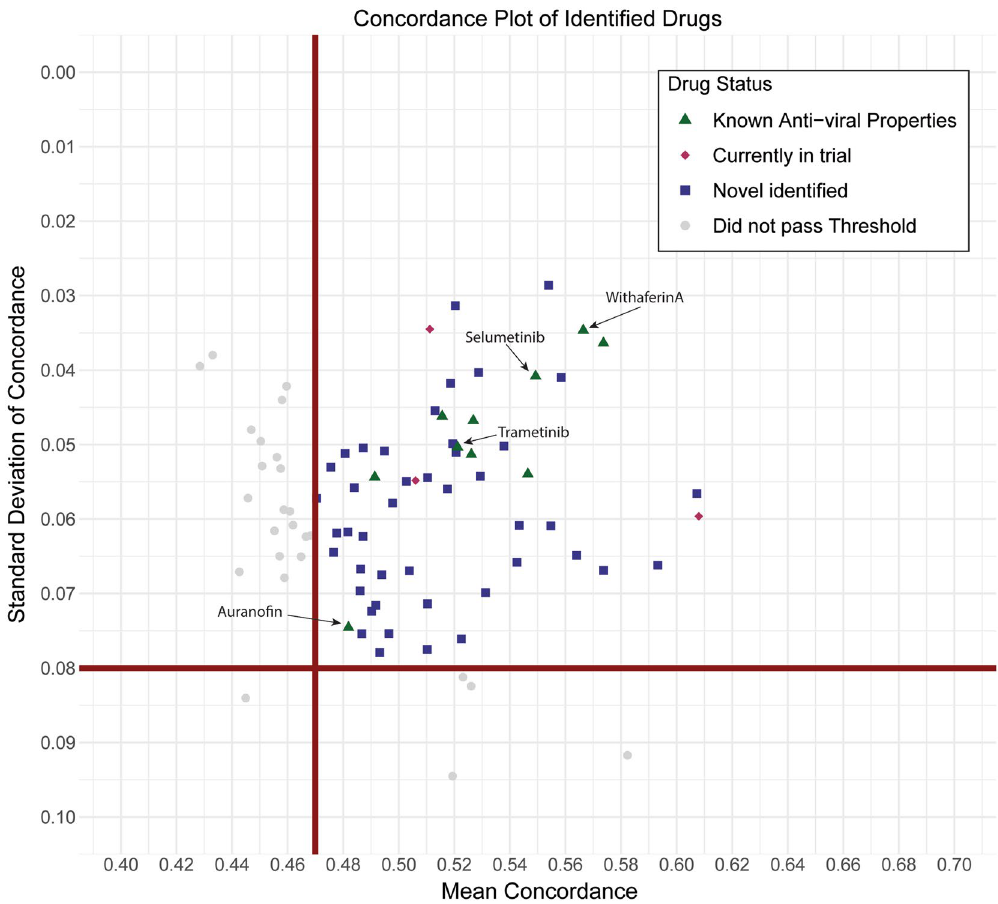
Figure 2. Scatter plot of average reported concordance scores and standard deviation (SD) of reported concordance scores for candidate drugs. A total of 83 FDA approved drugs were identified in the SARS-CoV-2 A549_ACE2 dataset (GSE147507 CL). 57 drugs were identified with a minimum mean concordance score 0.47and SD ≤ 0.08 (squares). Drugs above this threshold are considered “candidate” drugs. Top candidate drugs, those approved for use in humans and with demonstrated antiviral activity in vitro (filled triangles), those with SARS-CoV-2 antiviral efficacy specifically (inverted triangles) and those already in trial for COVID-19 (diamond) are also